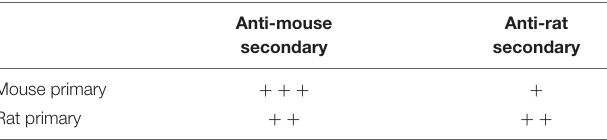
TABLE 3 | Hypothetical scaling of anti-mouse or anti-rat secondaries in binding ability to mouse and rat